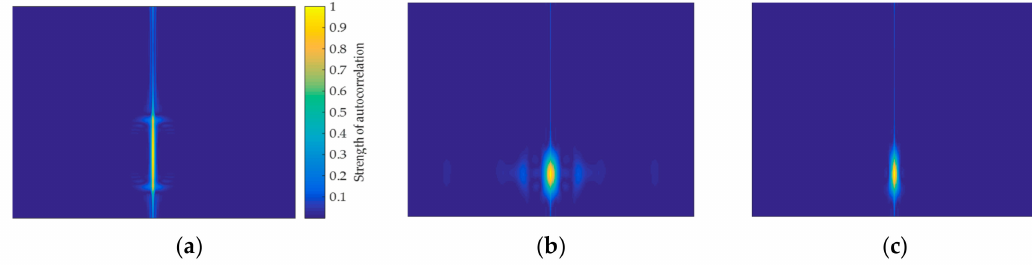
Figure 5. Autocorrelation feature images formed by LFM, T1, and P1 signal: ( a ) LFM; ( b ) T1; and, ( c )